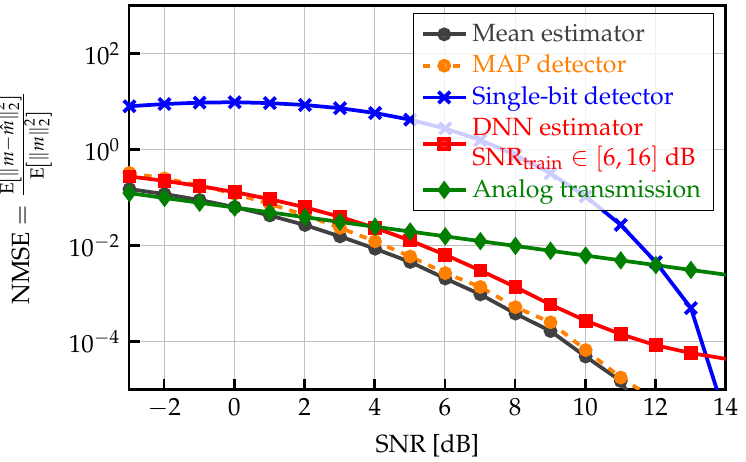
Figure 8. Normalized MSE (NMSE) as a function of Signal-to-Noise Ratio (SNR) for different non- and semantic exploration data receiver approaches. We assume uncoded digital BPSK transmission of gra- dients and models m of the distributed full seismic waveform inversion [22] over an AWGN